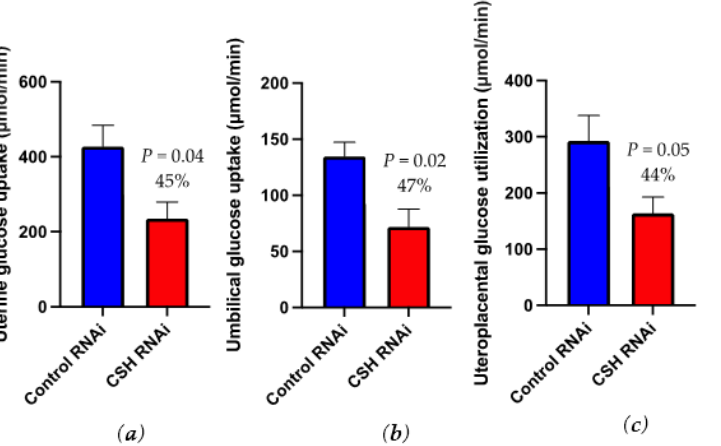
Figure 4. Uterine, umbilical, and uteroplacental glucose uptakes as assessed by 3 H 2 0 transplacental diffusion at 130 dGA: ( a ) uterine glucose uptakes, µmol/min ( b ) umbilical glucose uptakes, µmol/min; ( c ) uteroplacental glucose utilization, µmol/min. Data are shown as means ± SEM for all pregnancies in each treatment group. CSH, chorionic somatomammotropin; RNAi, RNA interfer-